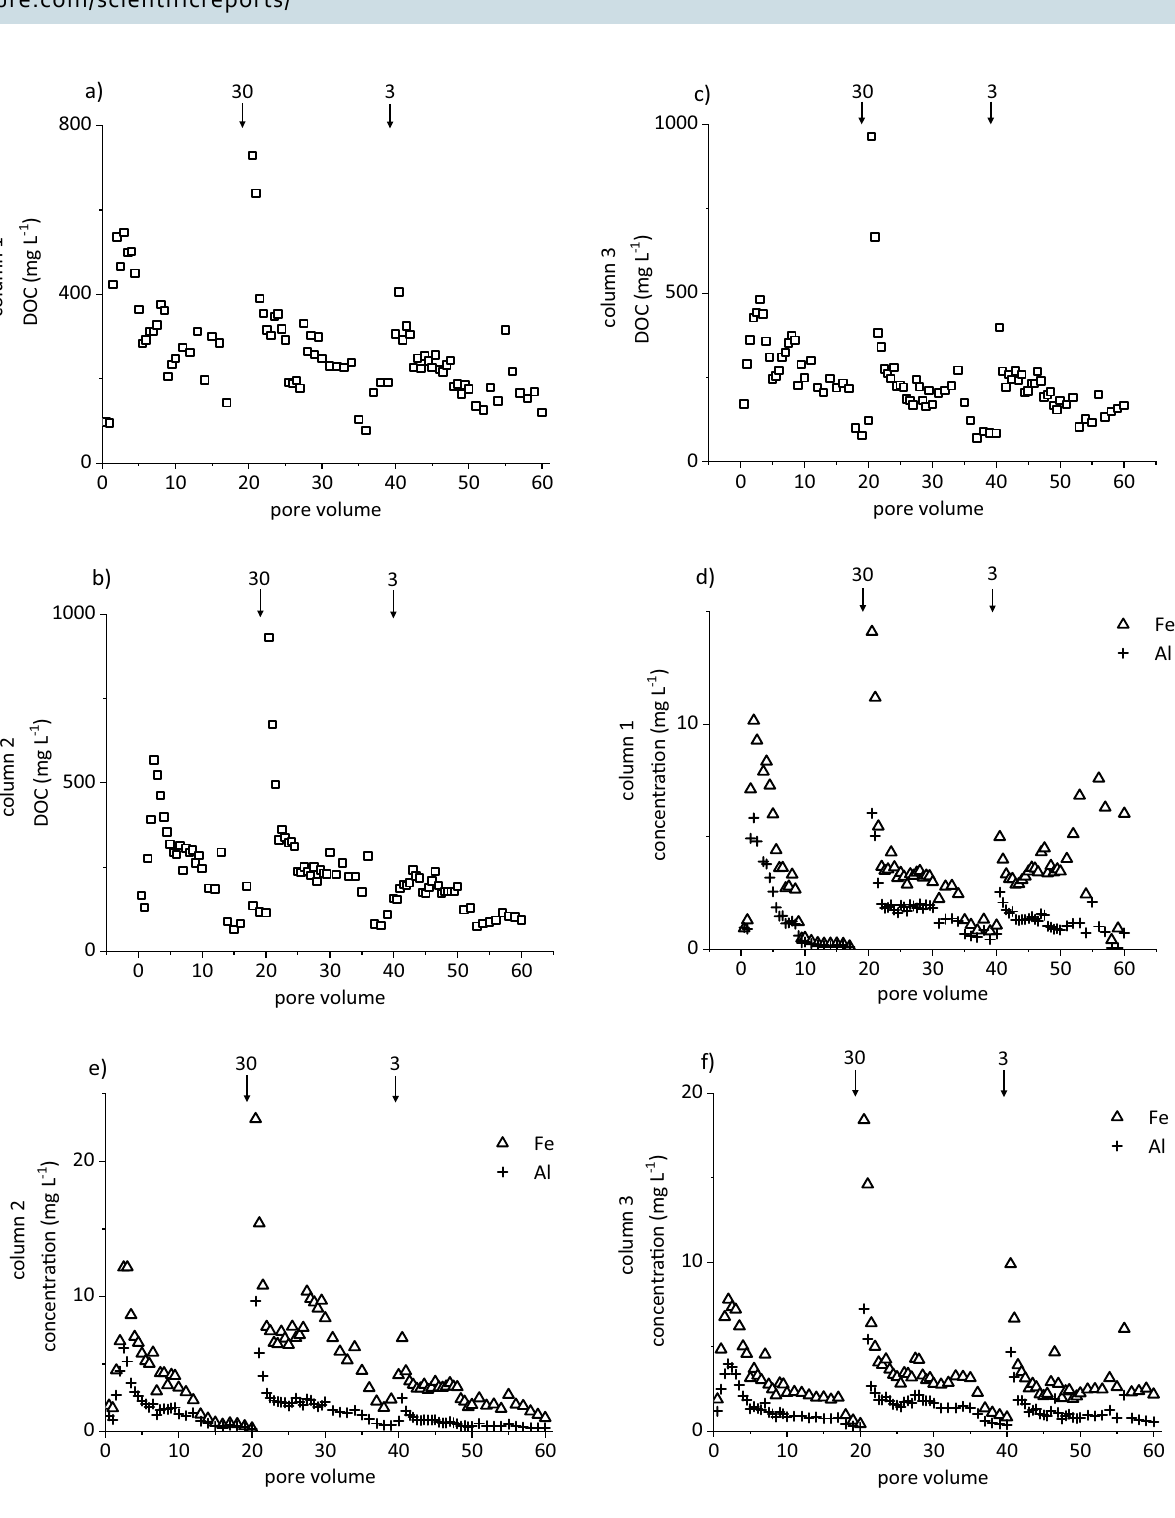
Figure 1. Concentrations of ( a – c ) dissolved organic carbon (DOC) and ( d – f ) Fe and Al in eluates from release experiments run at q = 1 mm h −1 with three soil cylinders taken from the AE horizon of a Dystric Arenosol. Arrows indicate flow interruptions and their duration in